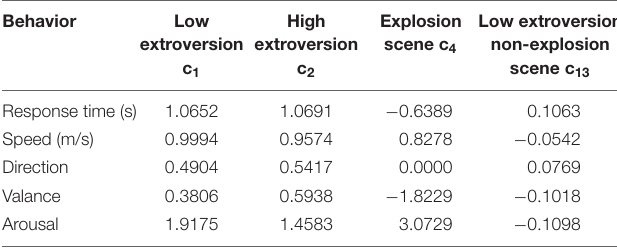
TABLE 9 | Interaction of extroversion and explosion scene on individual emotional impact and escape behavior. Behavior